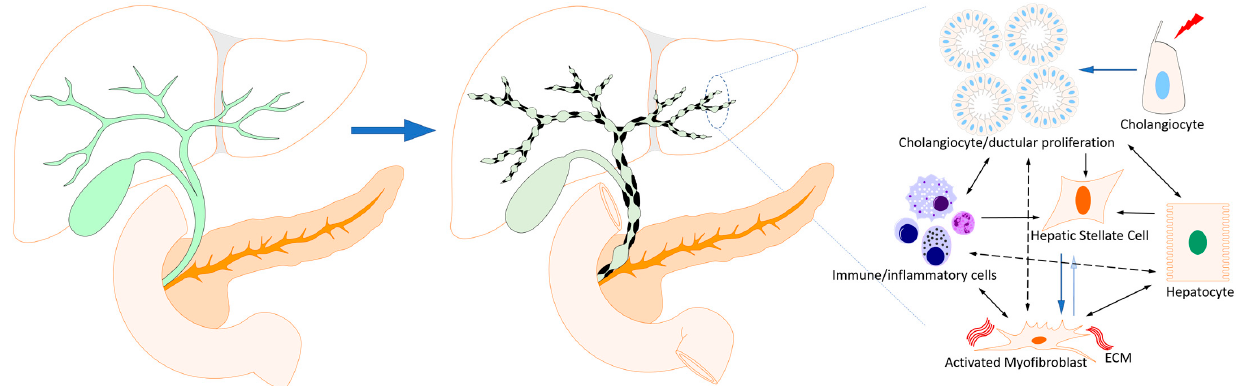
Figure 1. Cell ‐ to ‐ cell interactions in and mechanism of biliary fibrosis. Biliary fibrosis in PSC